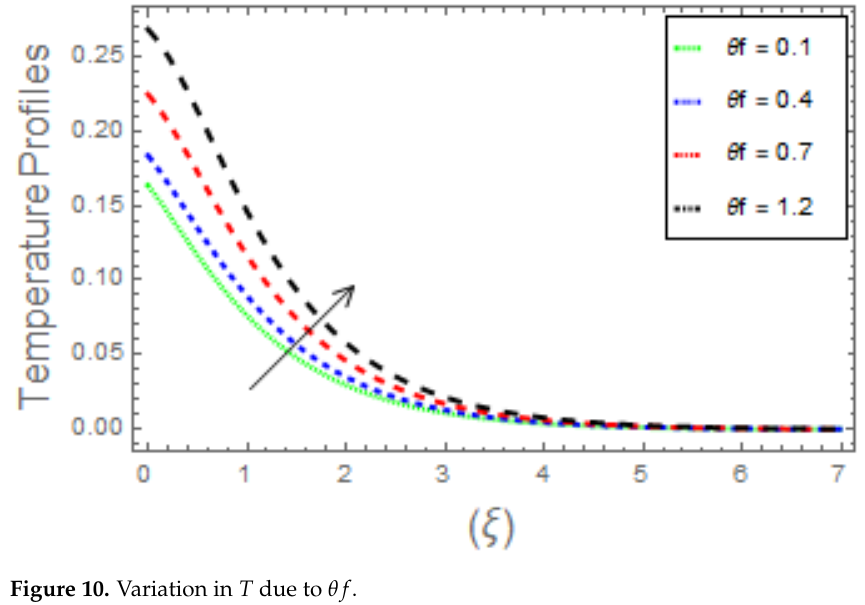
Figure 10. Variation in T due to θ f .